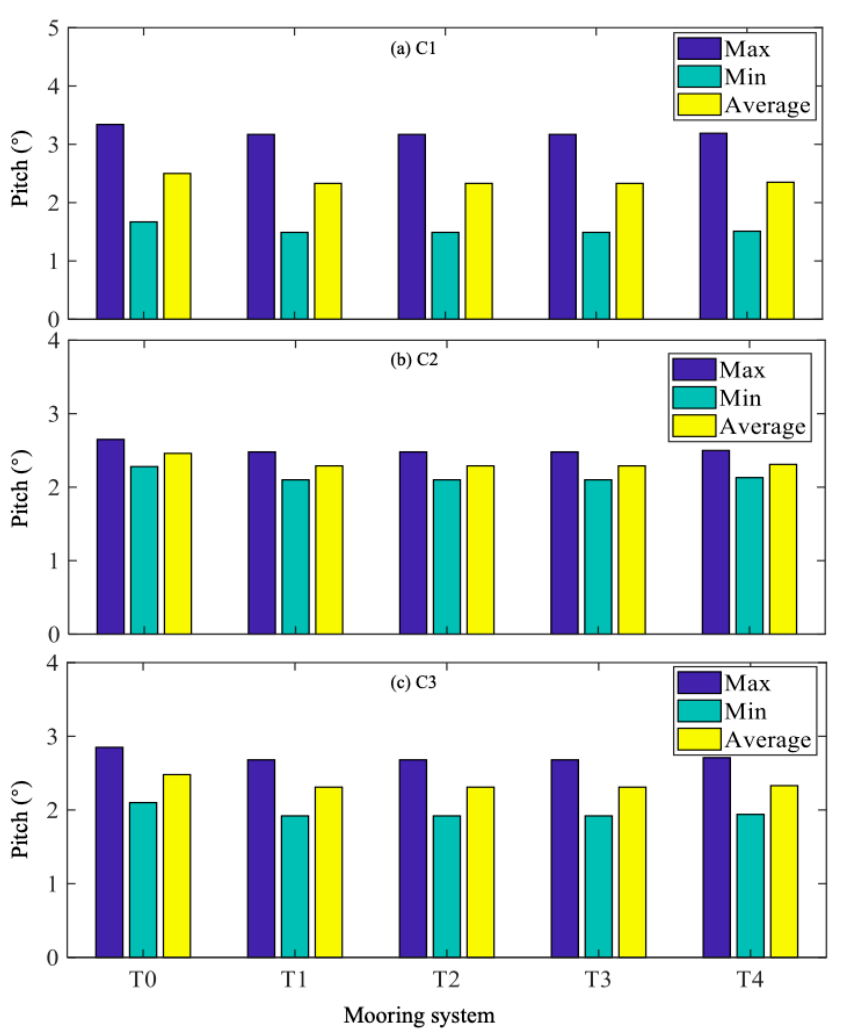
Figure 11. Pitch movement maximum, minimum, and average values in ( a ) C1, ( b ) C2, and ( c ) C3.